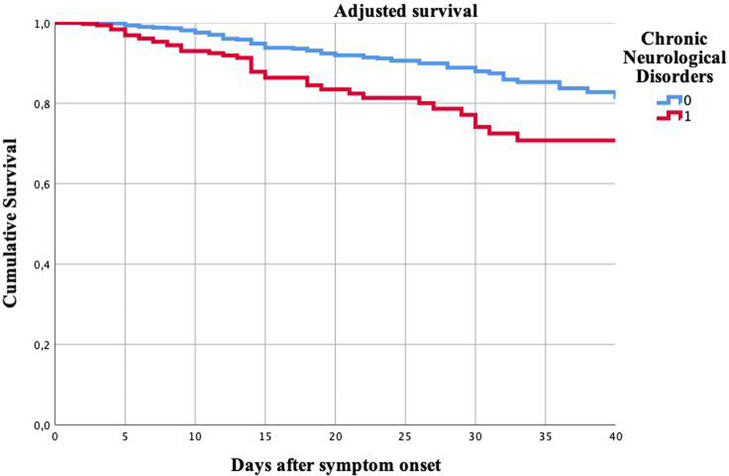
Cumulative survival of patients with and without chronic neurological disorders. Kaplan Meier curves. Y axis: Cumulative survival. X axis: Days after the symptoms onset.